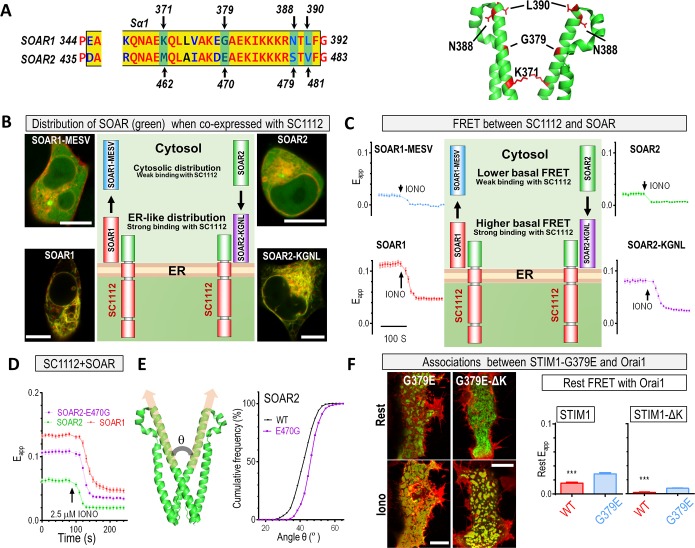
E470 residue in SOAR2 α1 region weakens its interactions with STIMCC1.(A) Four critical residues in the SOAR α1 region. Left: alignment of a partial sequence of the α1 region of SOAR1 and SOAR2, with the four critical residues indicated by arrows. Right: cartoon of a portion of a SOAR1 dimer crystal structure, with the four residues marked in red. (B–C) Comparative analysis of YFP-SOAR1, YFP-SOAR1-MESV, YFP-SOAR2, and YFP-SOAR2-KGNL constructs coexpressed with SC1112-CFP in HEK293 cells. (B) Typical confocal images of the distribution of the cytosolic SOAR constructs (green) and SC1112-CFP (red) (scale bar, 10 μm). Middle: cartoons illustrating the effects of substitutions on subcellular distributions of SOAR molecules coexpressed with SC1112-CFP (at least 12 cells for each condition were examined each time; n = 3). (C) Representative traces of FRET signals between SC1112-CFP and SOAR constructs. Middle: cartoons illustrating the effects of substitutions on FRET signal. (D) Typical traces showing the effect of E470G substitution on the FRET signals between SC1112-CFP and SOAR2. (E) Results of computer simulations demonstrating the effect of the E470G substitution on the angle between SOAR2 monomers. (F) FRET signals (bar graphs) and confocal images (left) demonstrating the associations or colocalization of Orai1 and STIM variants. Scale bar, 10 μm (n = 3, ***P < 0.001, t test). Individual numerical values underlying (C)–(F) may be found in S1 Data. CC1, coiled-coil 1; CFP, cyan fluorescent protein; ER, endoplasmic reticulum; FRET, Förster resonance energy transfer; HEK293, human embryonic kidney cells; IONO, ionomycin; KGNL, M462K-E470G-S479N-V481L; MESV, K371M-G379E-N388S-L390V;SC, STIM1-CC1 construct; SOAR, STIM-Orai–activating region; STIM, stromal interaction molecule; WT, wild type; YFP, yellow fluorescent protein.